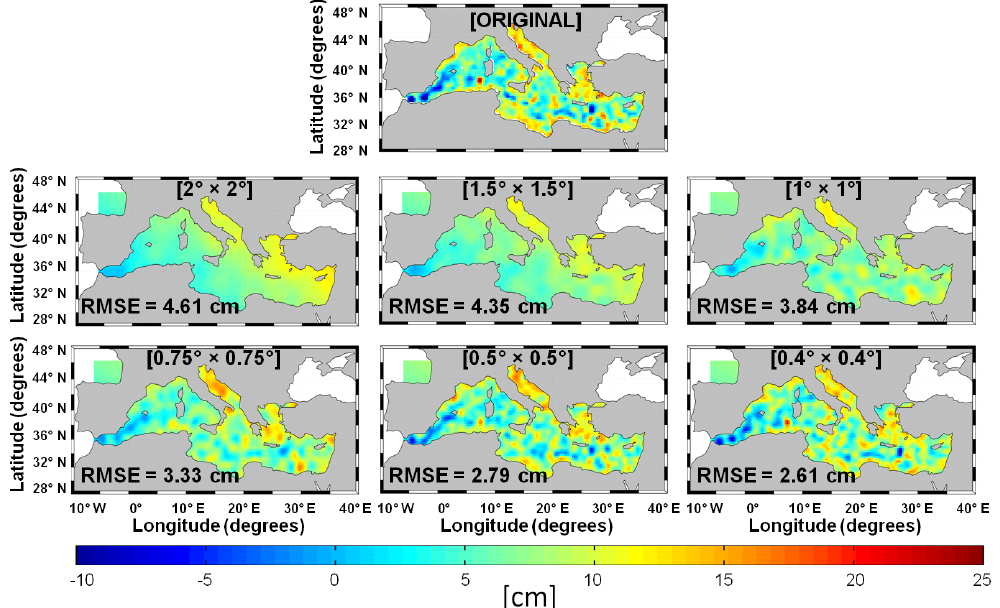
Figure 6. Altimetry maps recovered from the different sub-sampled SLA fields (cm) on 22 December 2014. The spatial resolution of the different regular grids and the RMSEs associated with each reconstruction for that day are also indicated. Moreover, the original SLA field of that day, interpolated to a spatial resolution of 1 / 3 ◦ × 1 / 3 ◦ , is displayed in the uppermost panel for comparison